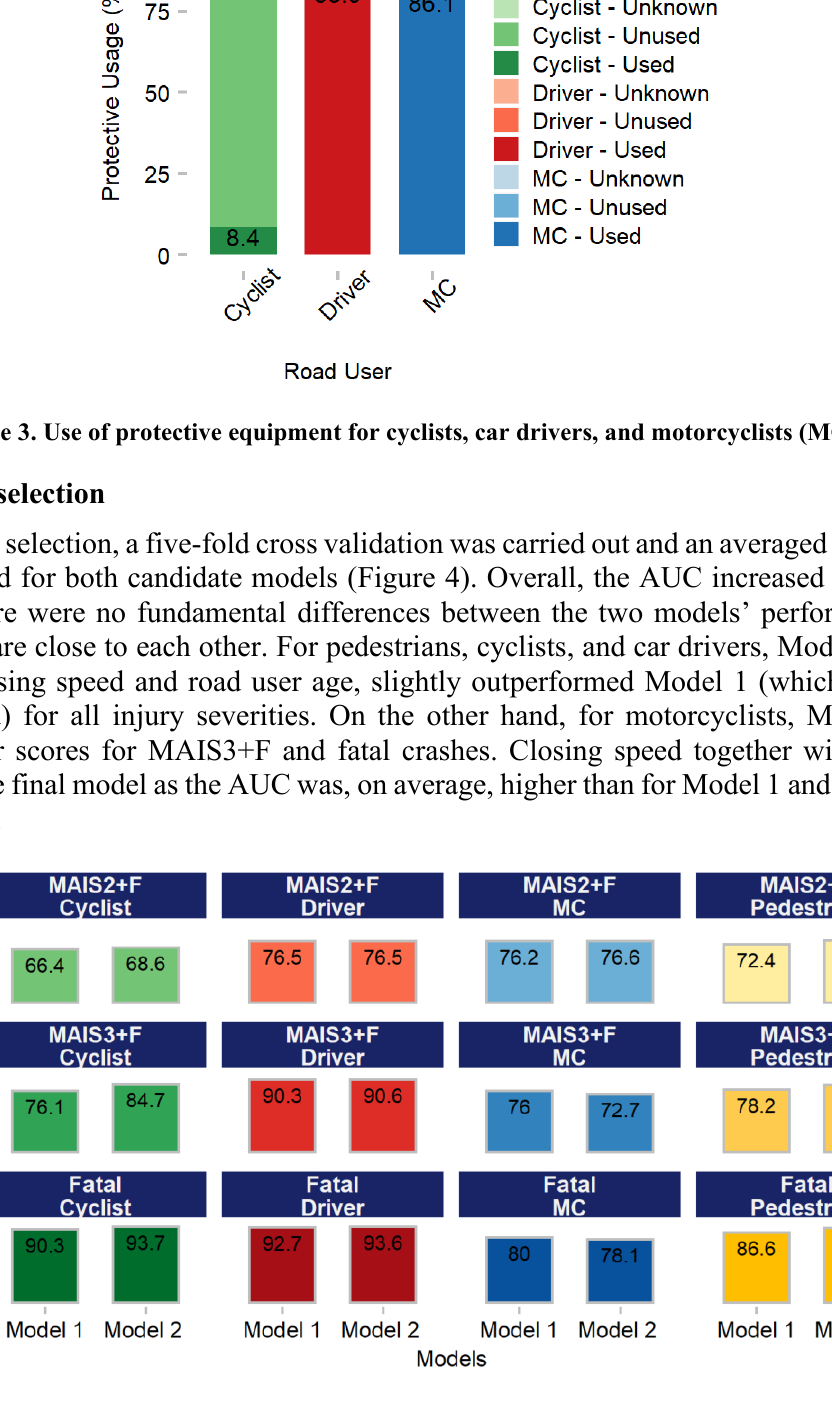
Figure 4. Candidate model performance measured by AUC. Model 1 consists of only closing speed and Model 2 consists of the combination of closing speed and road user